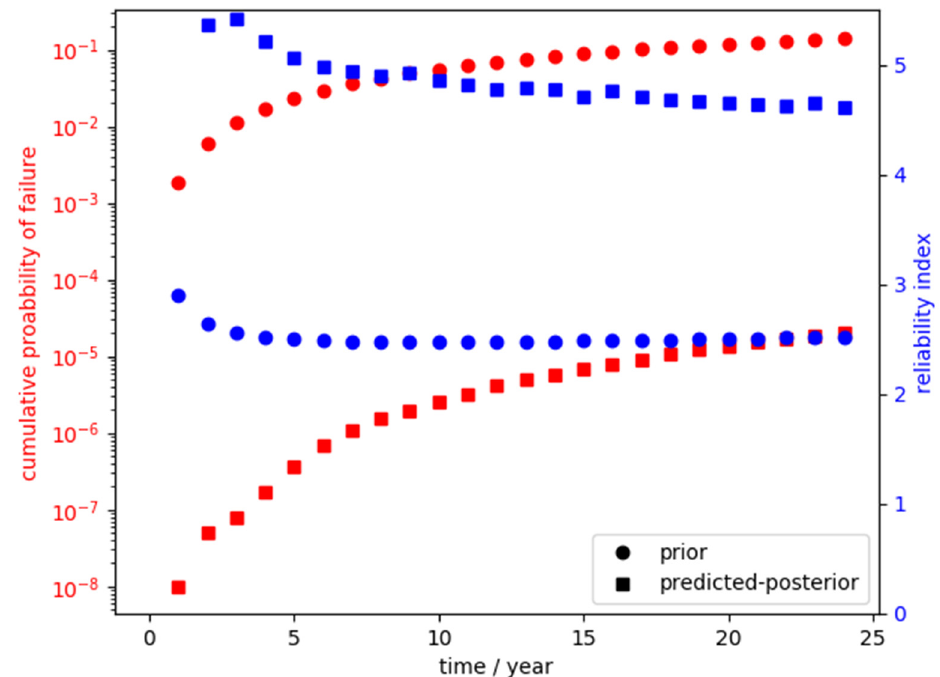
Figure 13. Cumulative probability of failure and annual reliability index of the welded joint deter- mined for the prior stress range distribution, 𝑓(Δ𝜎 (cid:3005)(cid:3032)(cid:3046)(cid:3036)(cid:3034)(cid:3041) ) , and the predicted posterior stress range distribution, 𝑓(Δ𝜎 (cid:3005)(cid:3032)(cid:3046)(cid:3036)(cid:3034)(cid:3041) |Δ𝜎 (cid:3014) ) , over the service life at position 1.